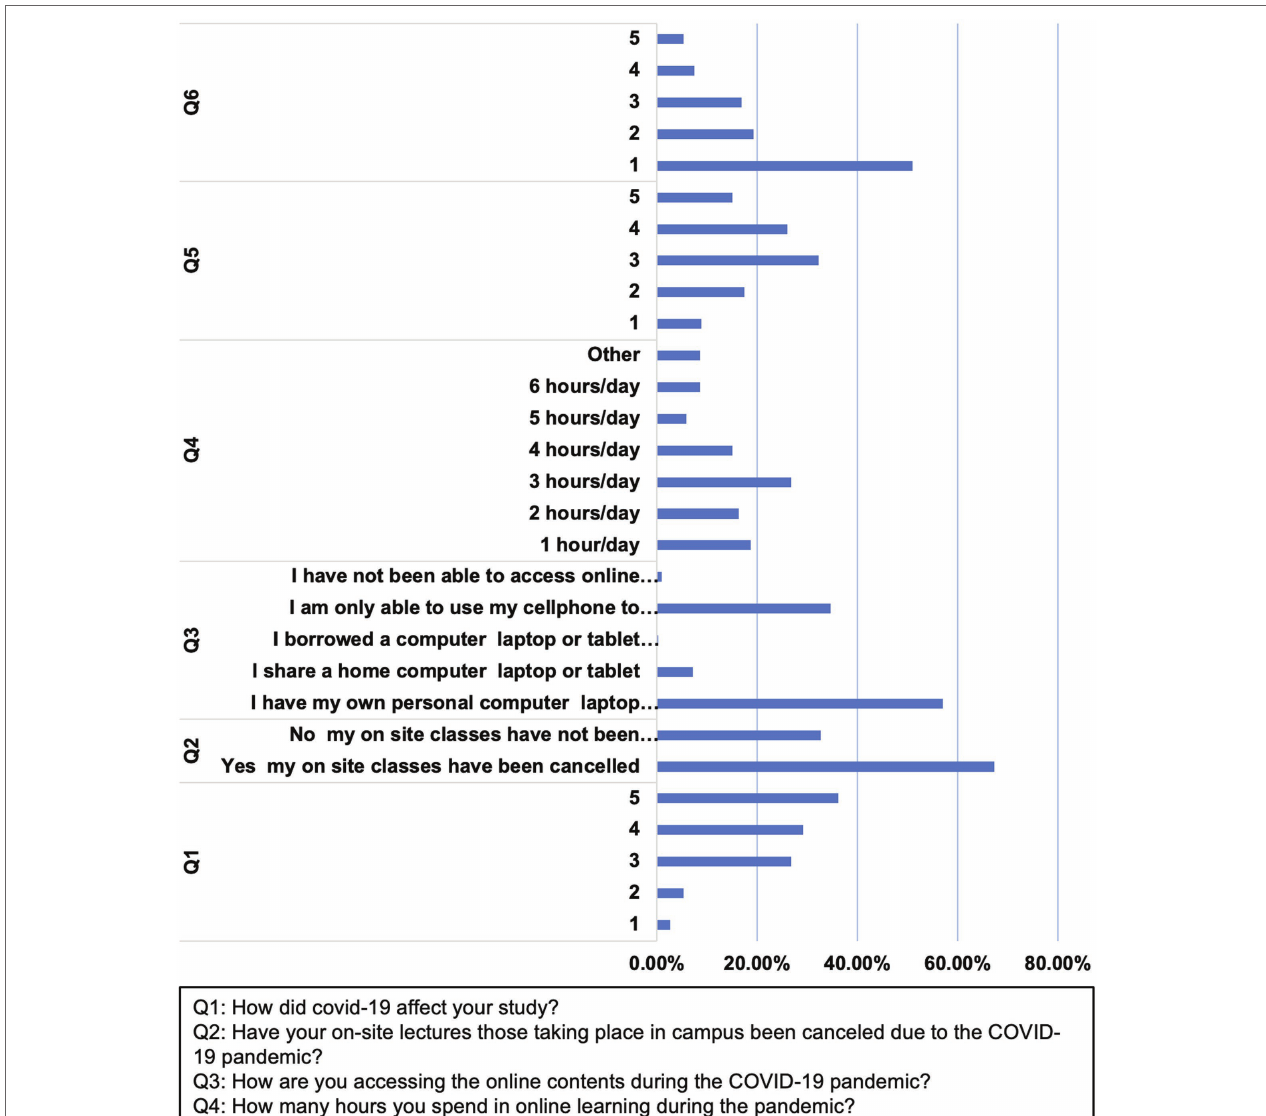
FIGURE 2 | Students’ responses to the survey on the impact of COVID-19 pandemic on the academic performance. The corresponding questions are as follows: Q1: How did COVID-19 affect your study? Q2: Were your on-site lectures on campus canceled due to the COVID-19 pandemic? Q3: How are you accessing the online content during the COVID-19 pandemic? Q4: How many hours do you spend in online education during the pandemic? Q5: How do you rate online lectures during COVID-19 pandemic? (1 is the lowest evaluation) Q6: How do you rate online practical lessons during COVID-19 pandemic? (1 is the lowest